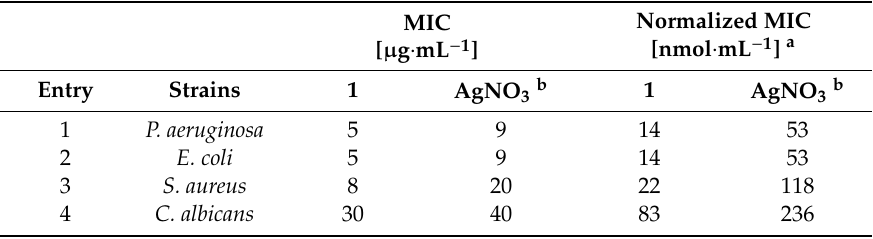
Table 1. Antimicrobial activity of 1 and AgNO 3 reference against di ff erent